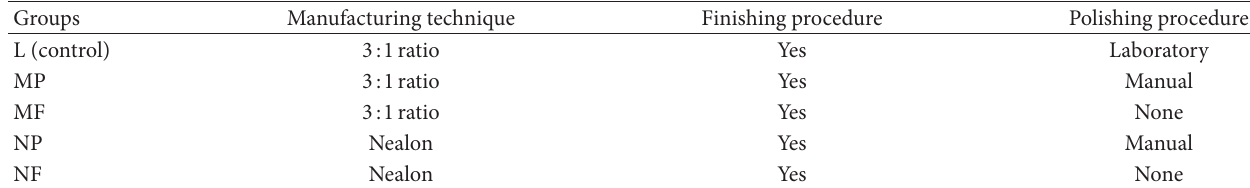
Table 1: Description of disc manufacturing technique,